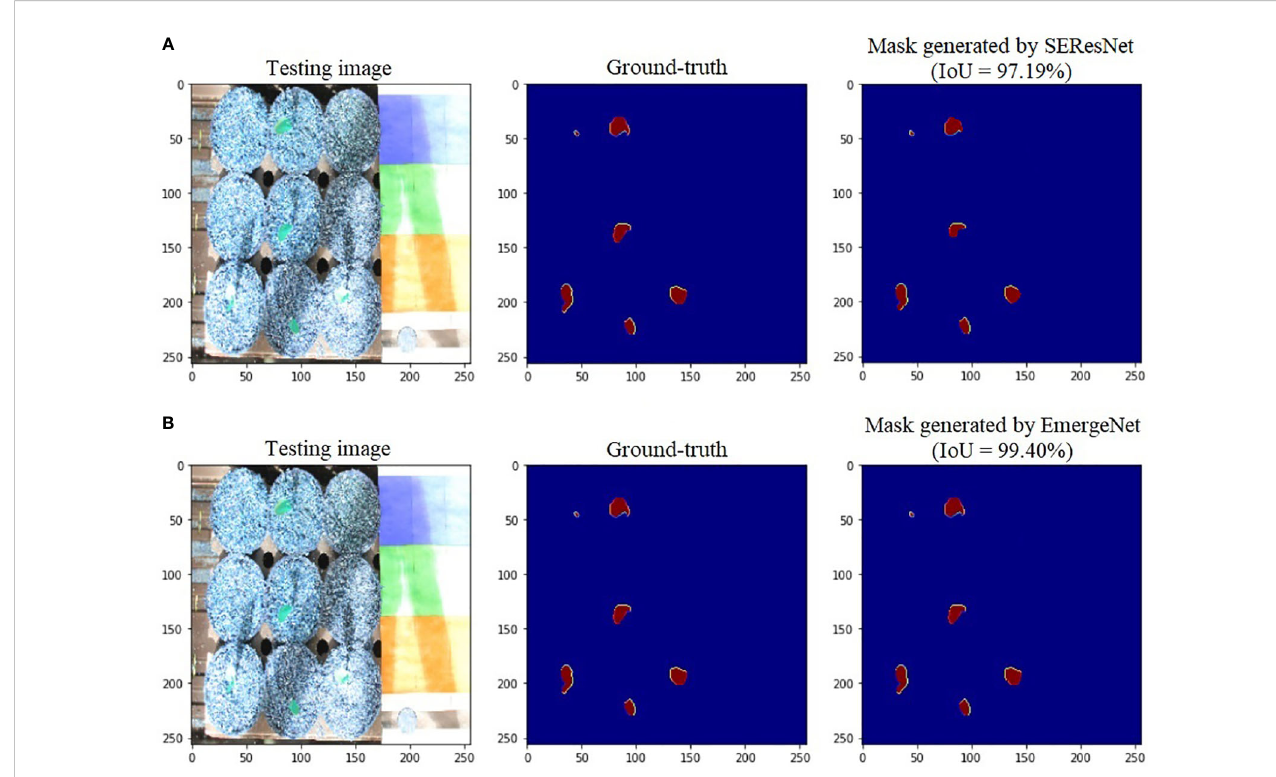
FIGURE 8 Illustration of segmentation performance on a test image from UNL-MED by (A) SEResNet and (B) EmergeNet.